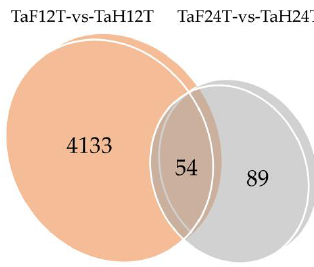
Figure 2. Venn diagram of 12 and 24 h common/specific differentially expressed lncRNAs. TaF12T, samples at 12 h inoculation with F. graminearum ; TaH12T, samples at 12 h inoculation with distilled water; TaF24T, samples at 24 h inoculation with F. graminearum ; TaH24T, samples at 24 h inoculation with distilled water. TaF12T-vs-TaH12T, differentially expressed wheat lncRNAs after 12 h inoculation with F. graminearum . TaF24T-vs-TaH24T, differentially expressed wheat lncRNAs after 24 h inoculation with F. graminearum .